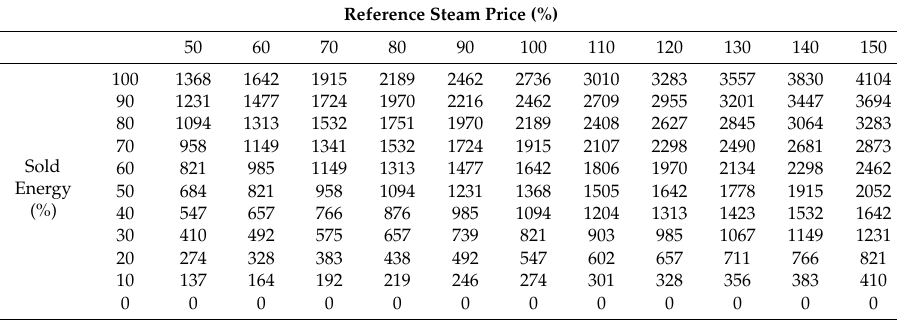
Table 7. Extra revenue obtained by participating in the steam market (in €